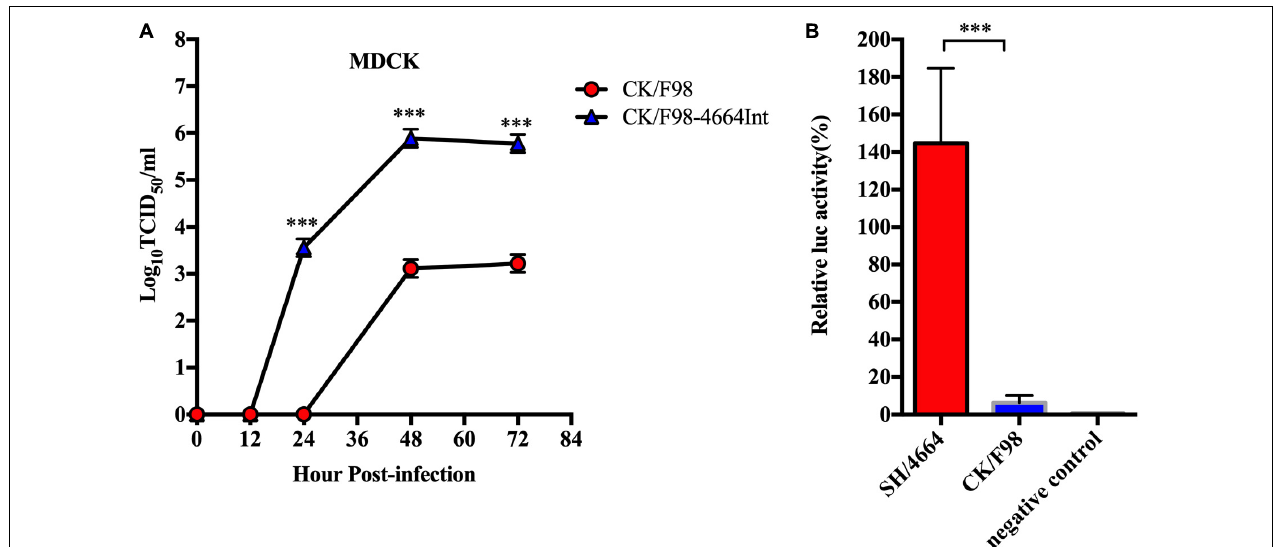
FIGURE 5 | Cell culture studies validated the superiority of H7N9 over H9N2 in their internal genes, likely the viral ribonucleoprotein complex, to support viral replication in mammal cells. (A) Multiple growth curves of CK/98 and CK/F98-4664Int virus in MDCK cells. MOI = 0.001. Virus titers in the supernatant at the indicated time points were determined by TCID50 using MDCK cells. Data represent one of three independent experiments, expressed as mean ± SEM. (B) Analyses of vRNP activity by minigenome assay. A set of four plasmids individually expressing PA1, PB1, PB2, and NP of CK/98 or SH/4664 was co-transfected into 293T cells with: (1) a reporter construct containing negative-sense Firefly luciferase gene flanked by the 5’ and 3’ ends of IAV NS1 gene; (2) a control reporter gene constitutively expressing Renilla luciferase. After 48 h, transfected cells were harvested, and vRNP activities were measured as Firefly:Renilla luciferase ratios. Error bars represent standard error from three biological replicates. *** P < 0.001, one way-ANOVA.